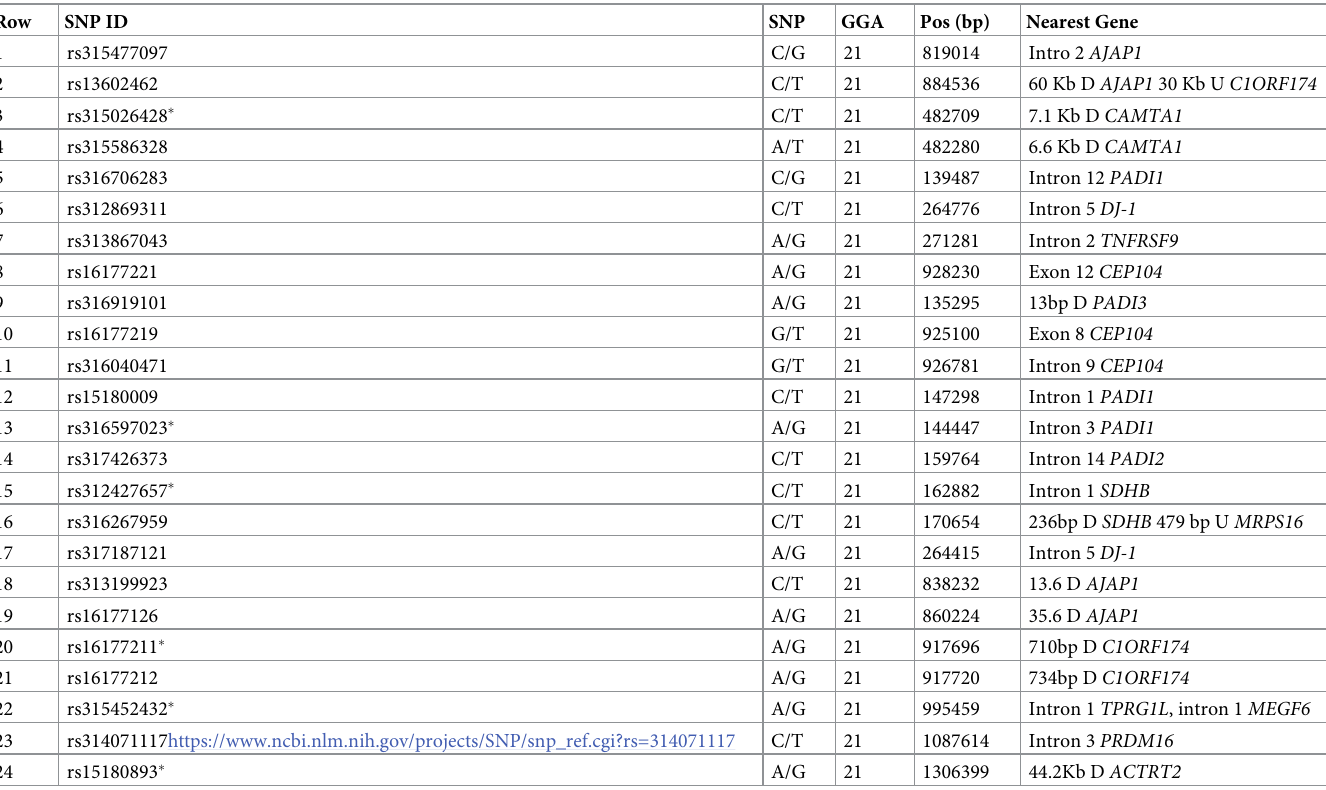
Table 3. Twenty-four SNP selected from GWAS for genotyping.